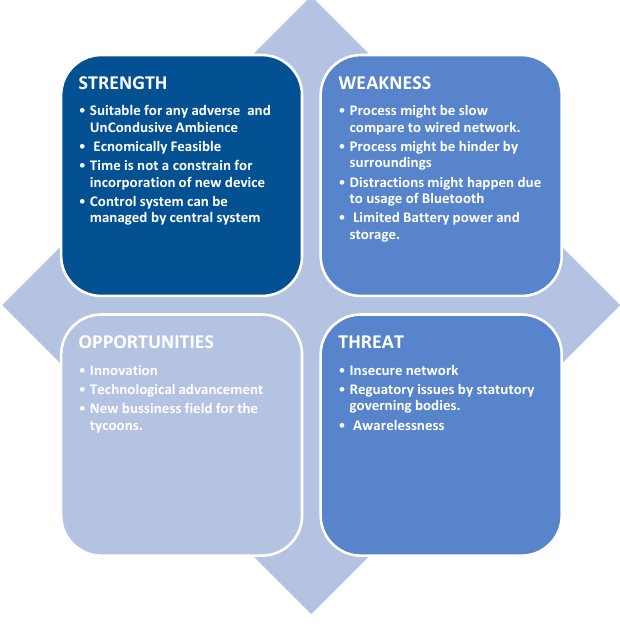
Figure9. SWOT (Strength, Weakness, Opportunities, and Threat) Analysis of WSNs. Figure 9. SWOT (Strength, Weakness, Opportunities, and Threat) Analysis of